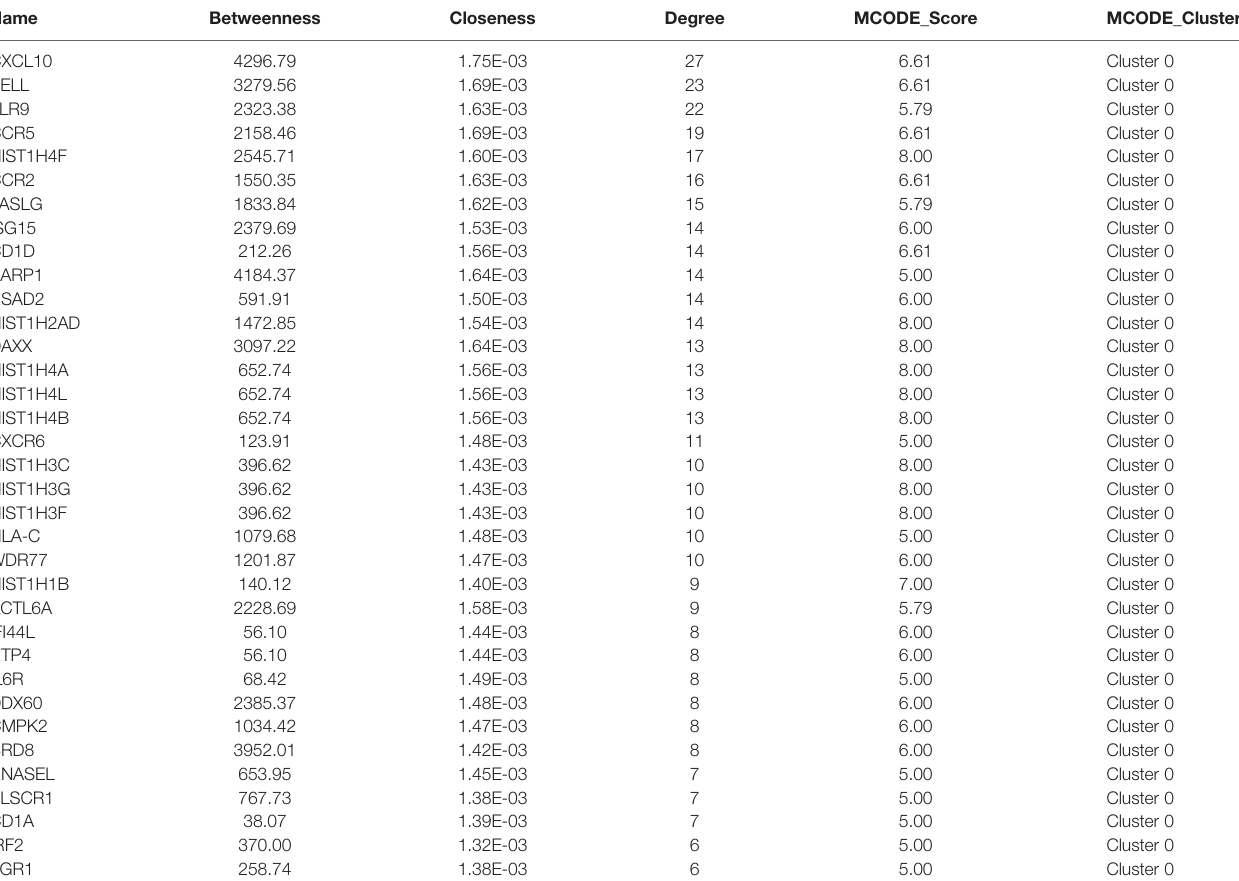
TABLE 2 | Results of Degree Centrality and MCODE analysis of down-regulated characteristic genes.